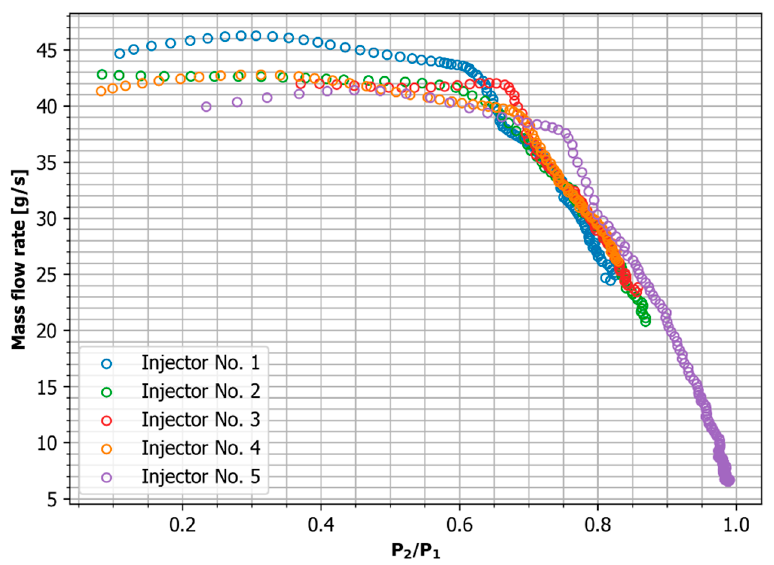
Figure 10. Mass flow rate versus the ratio of chamber pressure and upstream pressure for all injec- tors.